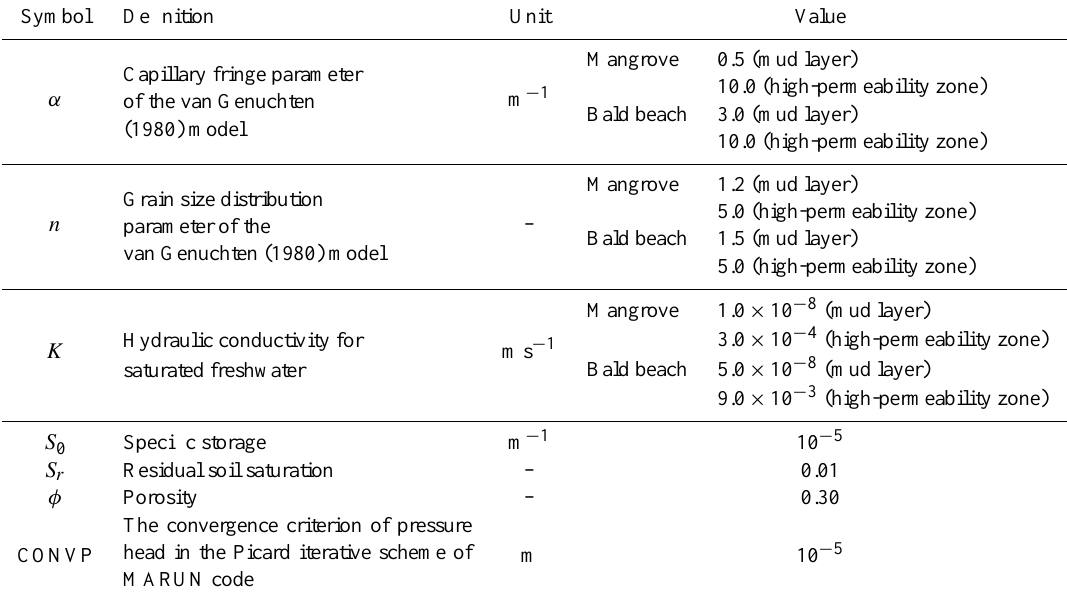
Table 5. Model parameter values used in the numerical simulations.